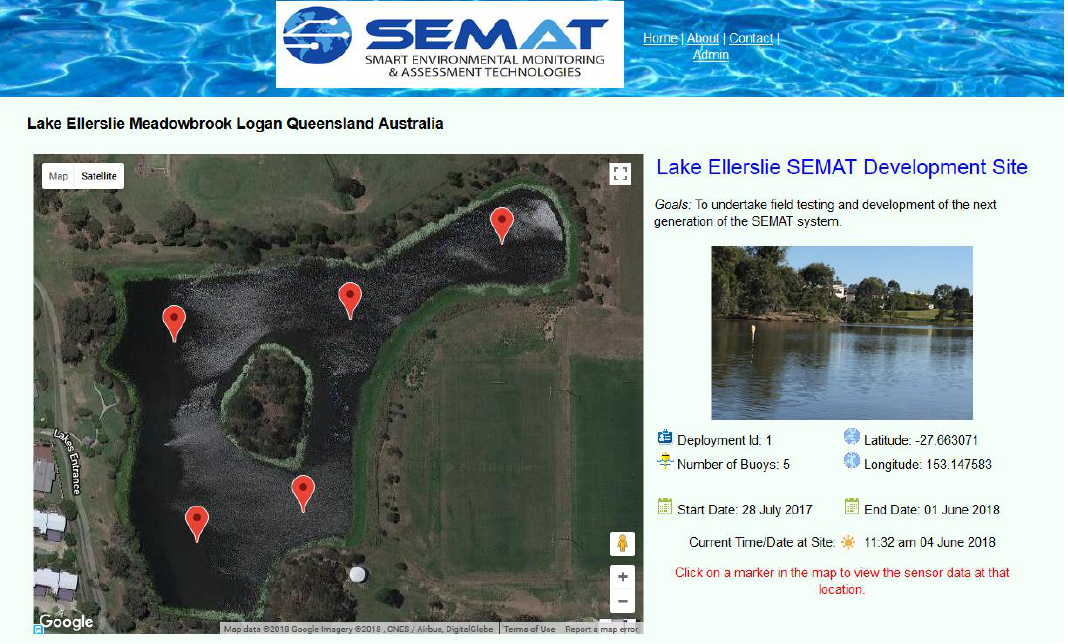
Figure 7. Web-Based User Interface.